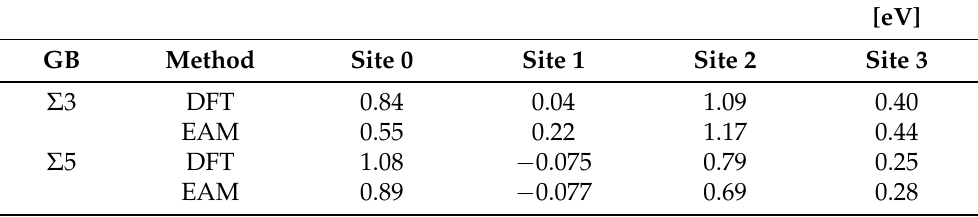
Table 2. P trapping energy of both GBs: DFT and EAM means the first-principles calculation and the MS simulation with the EAM potential, respectively. The DFT value of Σ 3 GB is cited from the paper [26] and the others were obtained in this